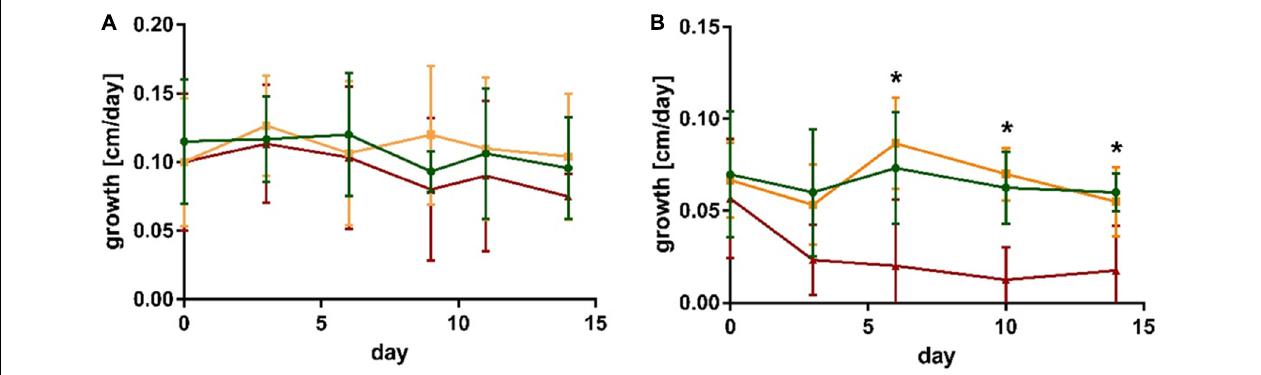
FIGURE 1 | Growth of (A) S. latissima and (B) L. digitata in control conditions (green), in presence of the non-endophytic M. tenuissimum (yellow) and the endophyte L. elsbetiae (red). The presented values are mean values with standard deviation ( N = 5). Significant differences are indicated by asterisk (see Supplementary Table 1 ).